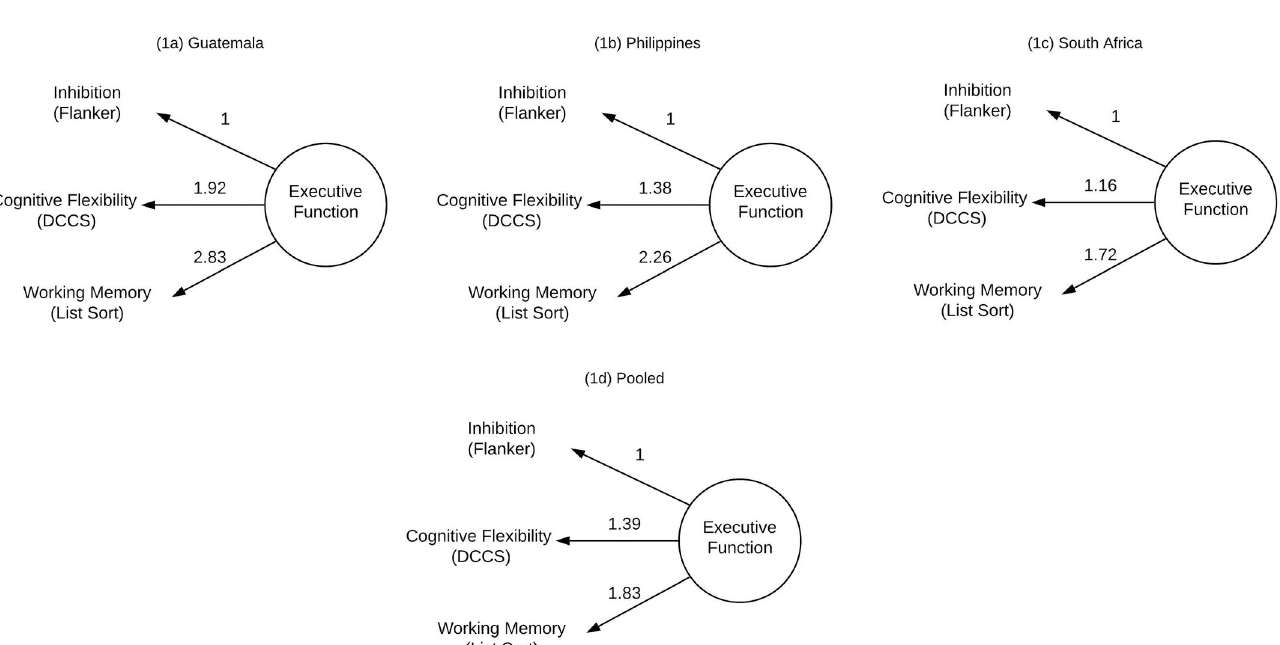
PLOS ONE | https://doi.org/10.1371/journal.pone.0242936 November30,